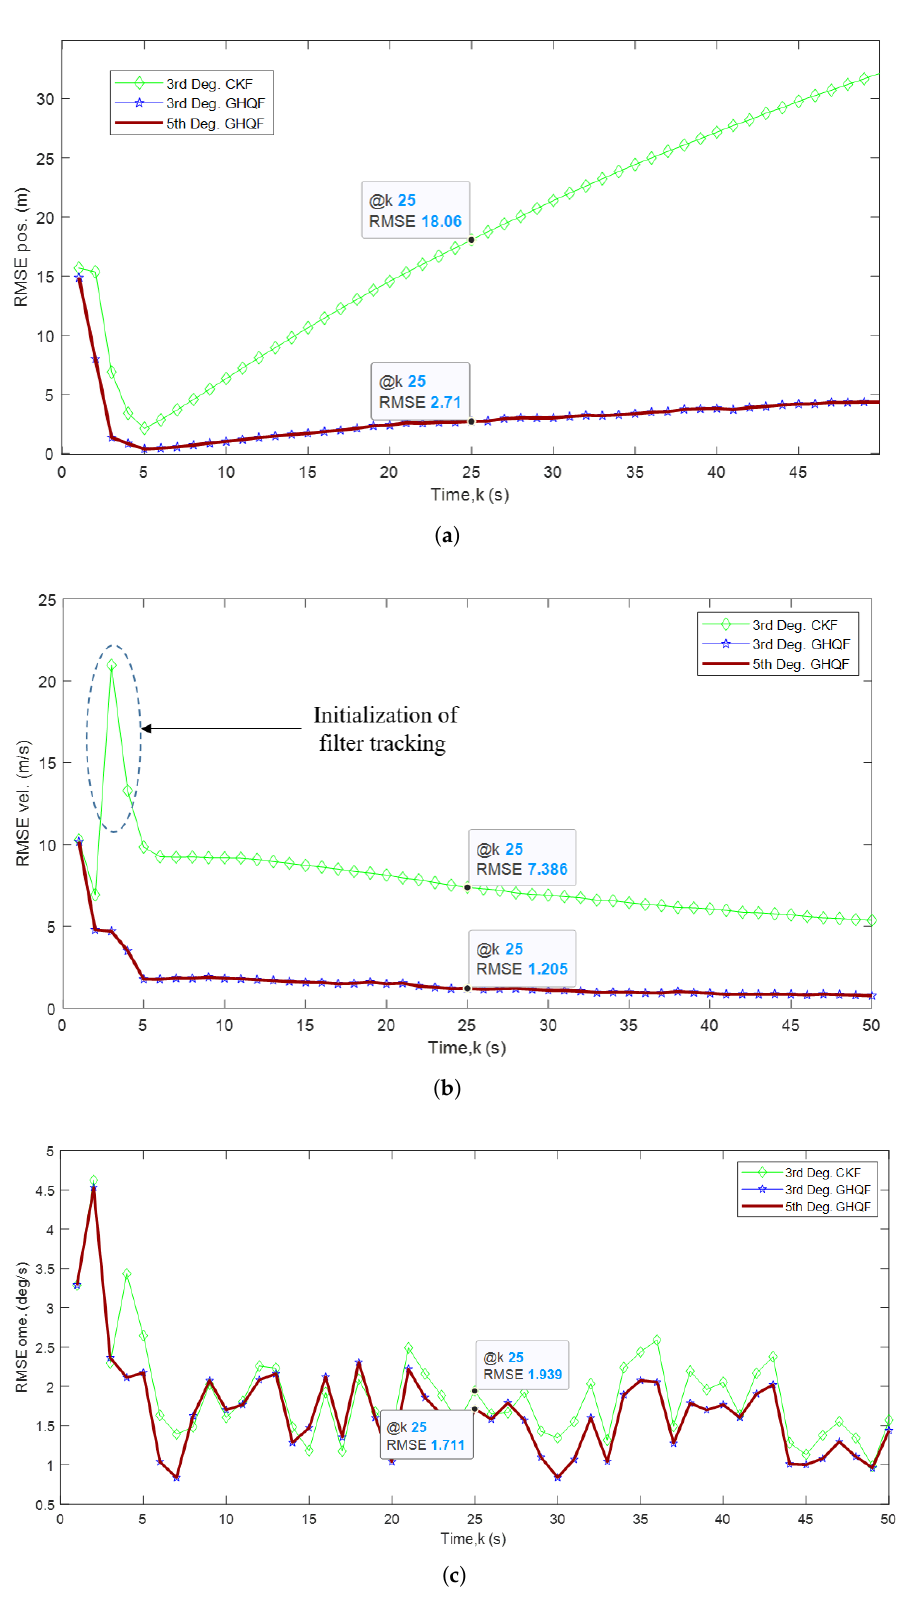
Figure 17. RMSE of GHQF approach based on FDOA: The performance result of GHQF 3rd-degree and 5th-degree approach compared to the CKF 3rd degree based on FDOA is better than the approach based on TDOA. ( a ) RMSE of position. ( b ) RMSE of velocity. ( c ) RMSE of